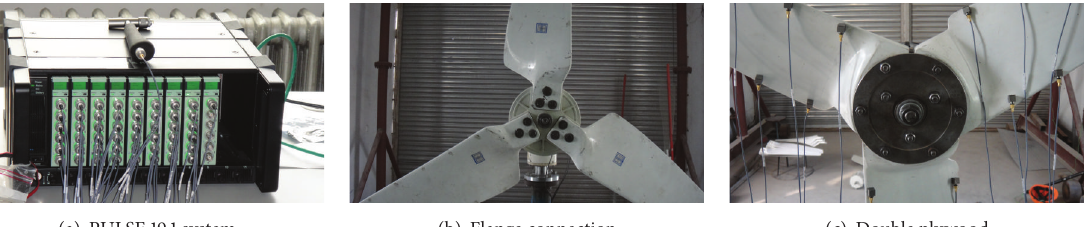
Figure 2: Modal testing.